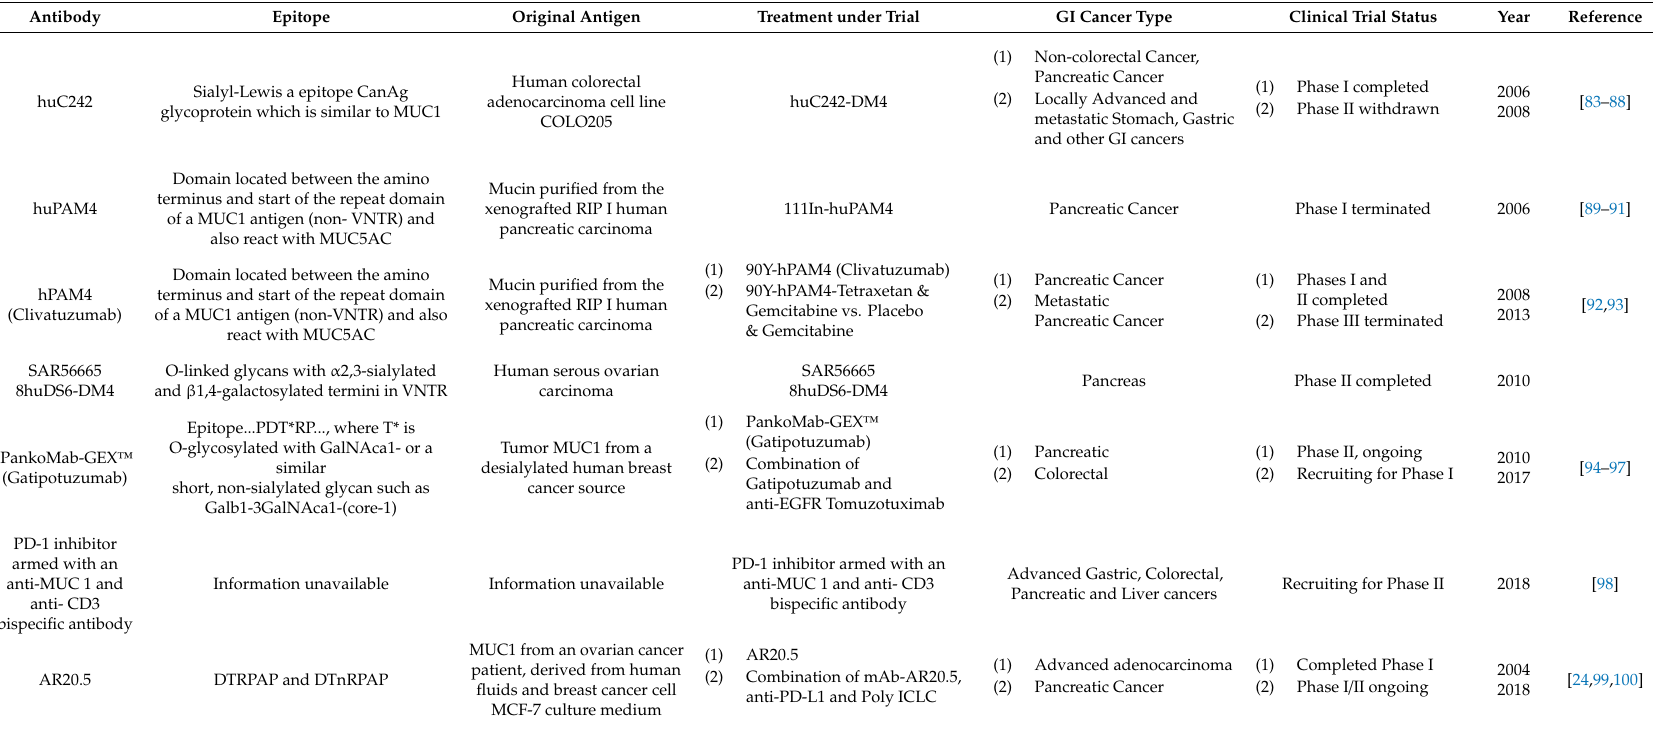
Table 2. MUC1 antibodies under clinical trials for GI